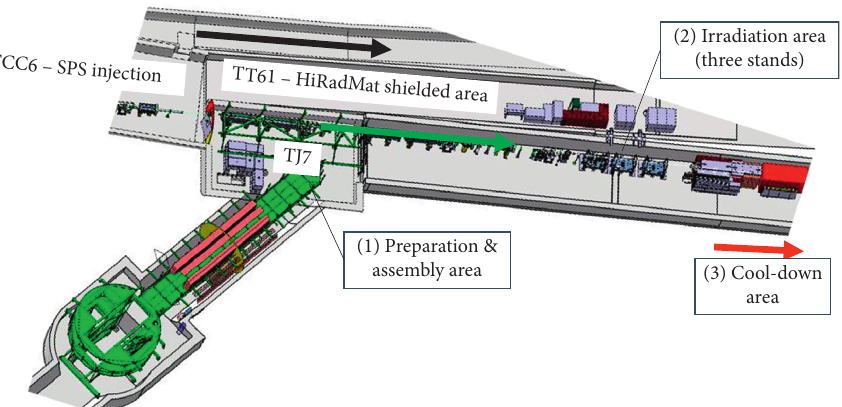
Figure 3: The different stages during the lifetime of an experiment in HiRadMat [11].